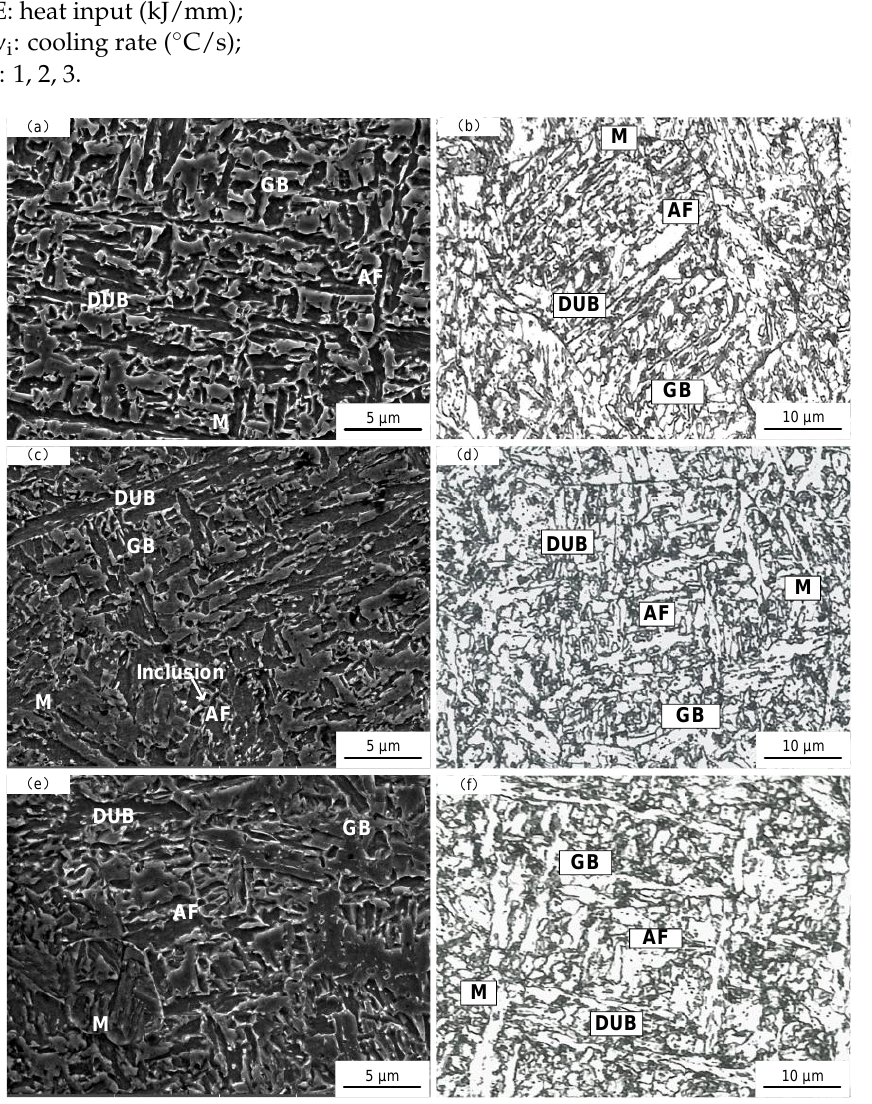
Figure 7. SEM images and optical micrographs of deposited metal under different heat inputs: ( a , b ) 1.45 kJ/mm; ( c , d ) 1.78 kJ/mm; ( e , f ) 2.31 kJ/mm.